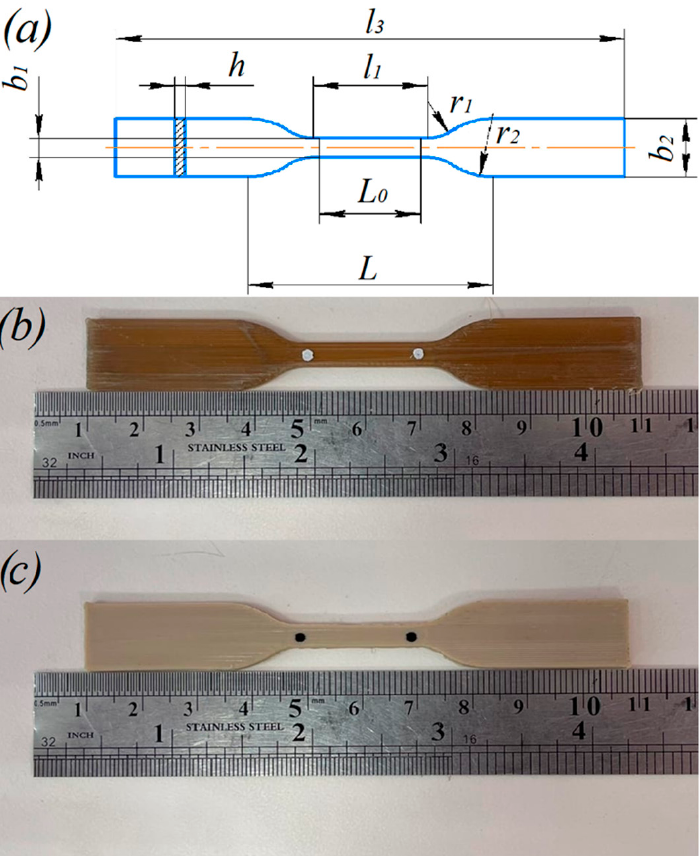
Figure 2. ( a ) Geometry of standard tensile test sample. PEEK sample without ( b ) and with ( c ) heat